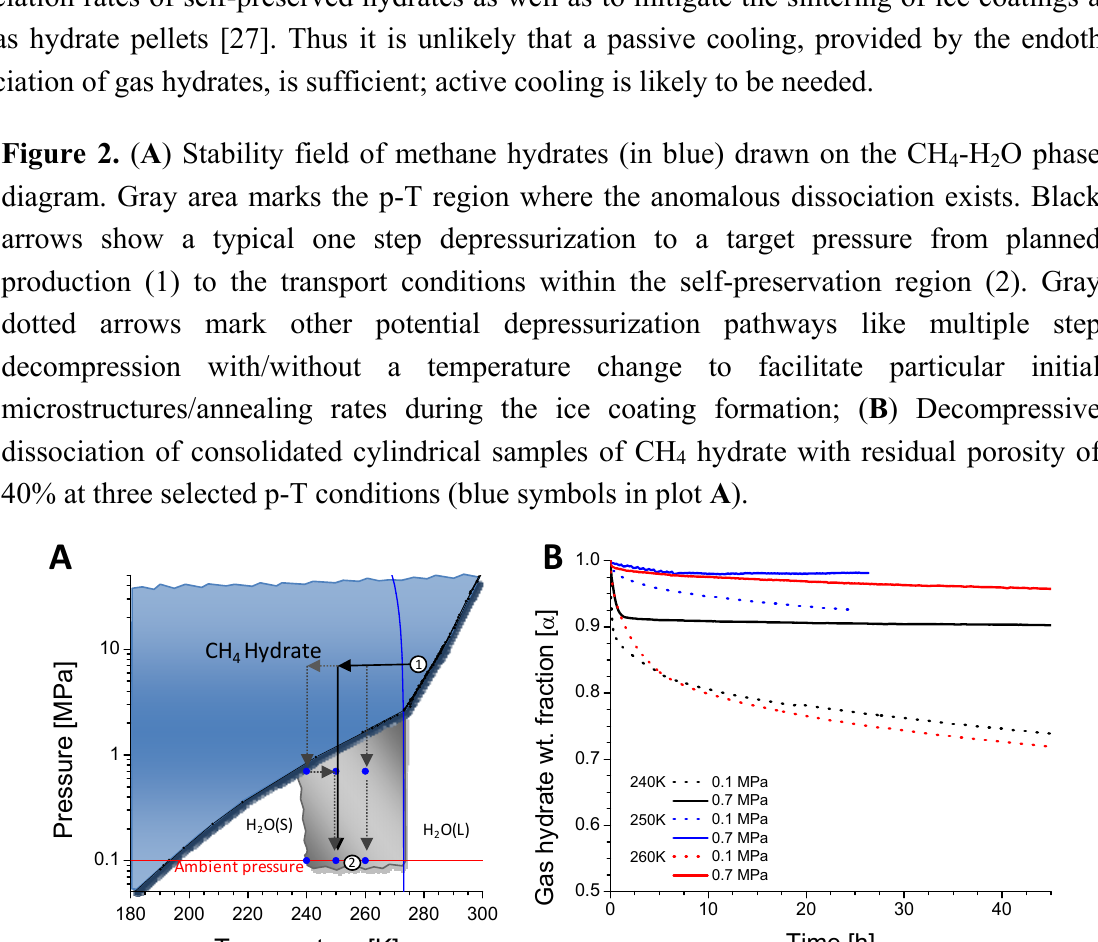
diagram. Gray area marks the p-T region where the anomalous dissociation exists. Black